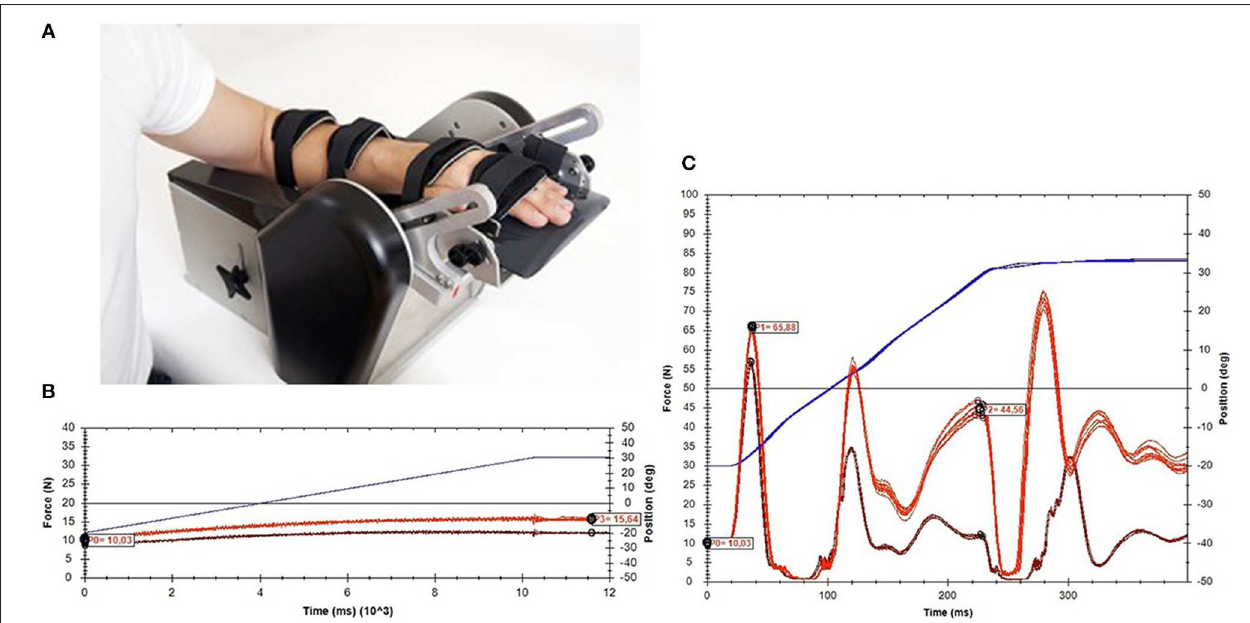
FIGURE 1 | NeuroFlexor method. (A) Measurement set-up. (B) An example of data obtained during slow movements (5 ◦ /s). (C) An example of data obtained during fast movements (236 ◦